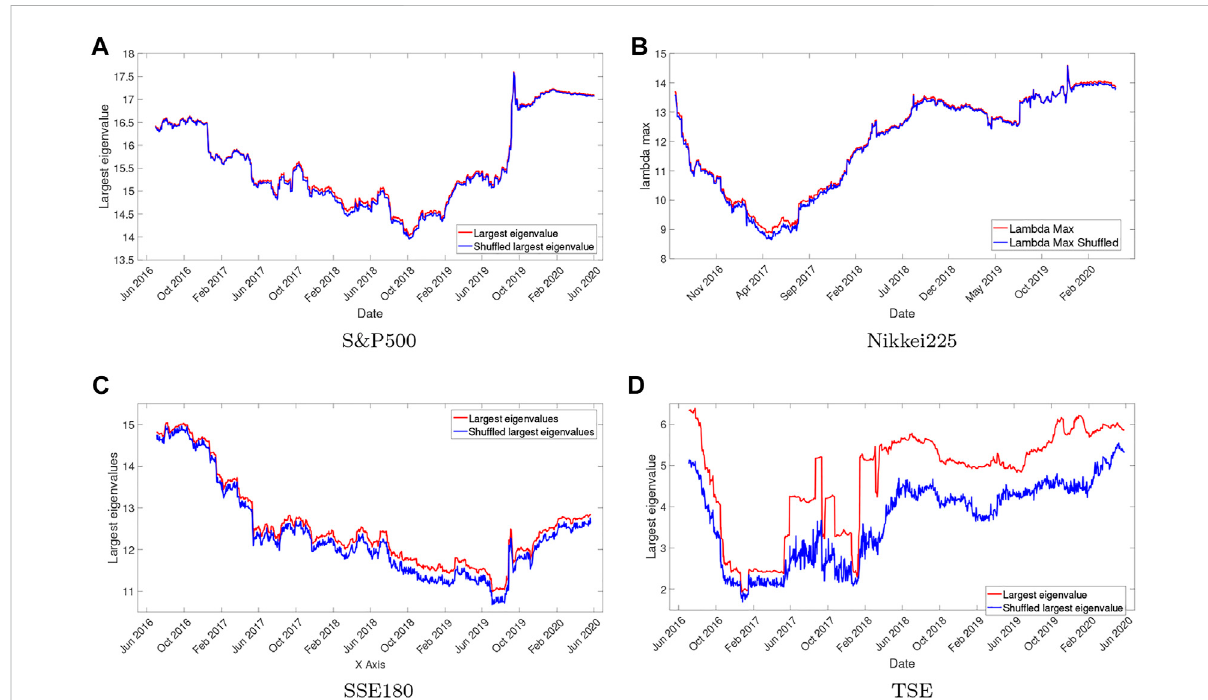
FIGURE 3 The largest eigenvalues of correlation matrix Vs. largest eigenvalues of the shuf fl ed matrix in markets from March 2016 to December 2020 are plotted.Theslidingyearlywindowisusedwithdiscretestepsof1day.InTsedistancebetweenthetwographsishigh,whichindicatesthatthemarket behavior is not random and there is a dominant collective mode. (A) S&P500, (B) Nikkei225, (C) SSE180, (D)